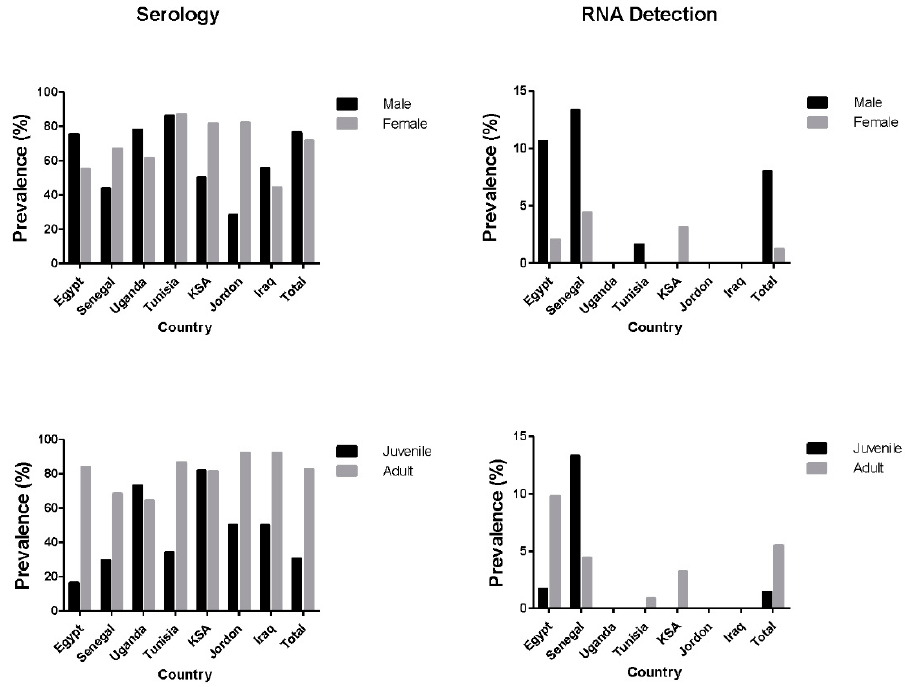
Figure 2. Comparison of the prevalence rate of MERS-CoV antibodies in serum (left) and RNA detection in nasal swabs (right) collected from camels in seven countries under investigation by age and sex.